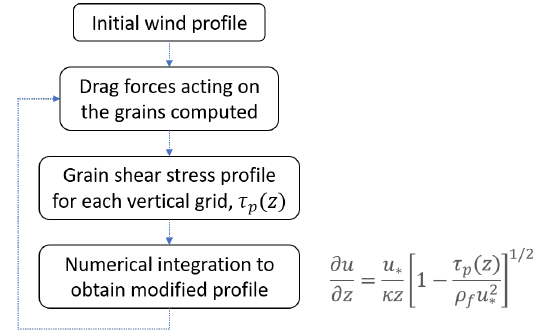
Figure 2. Workflow of the vertical wind profile computation.